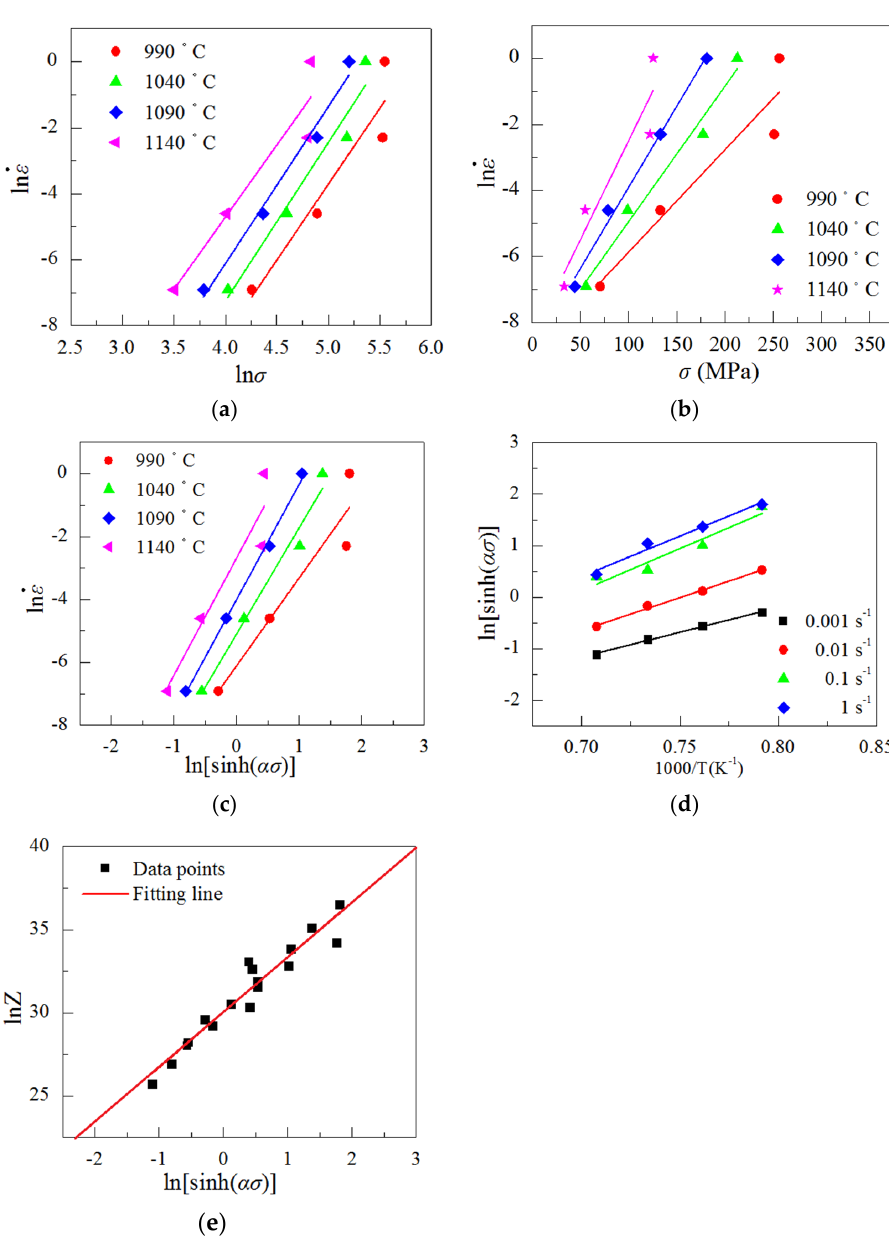
. ε − ln σ 0.3 , ( b ) ln